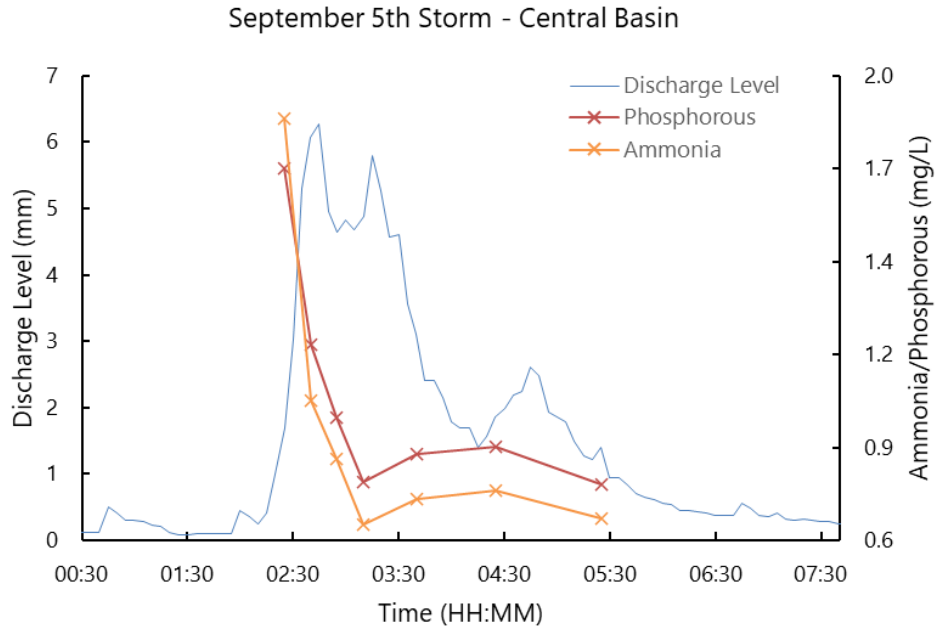
Figure 3. Discretely analyzed storm showing evidence of first-flush effect for phosphorous and ammonia at the Central basin for the storm occurring on 5 September 2018. The blue line represents the hydrograph and the orange line represents the phosphorus concentration.